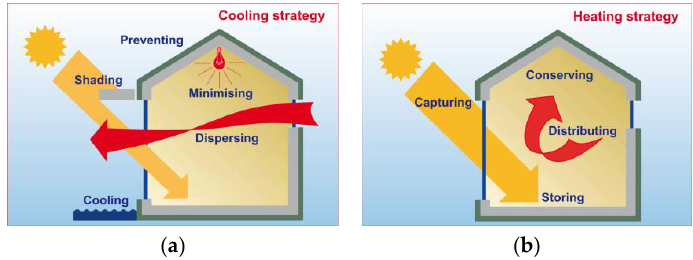
Figure 4. ( a ) The cooling strategy, reduce calorie intake and promote refreshment; ( b ) The heating strategy promotes free heat gains and reduces thermal experts, while allowing sufficient air renewal